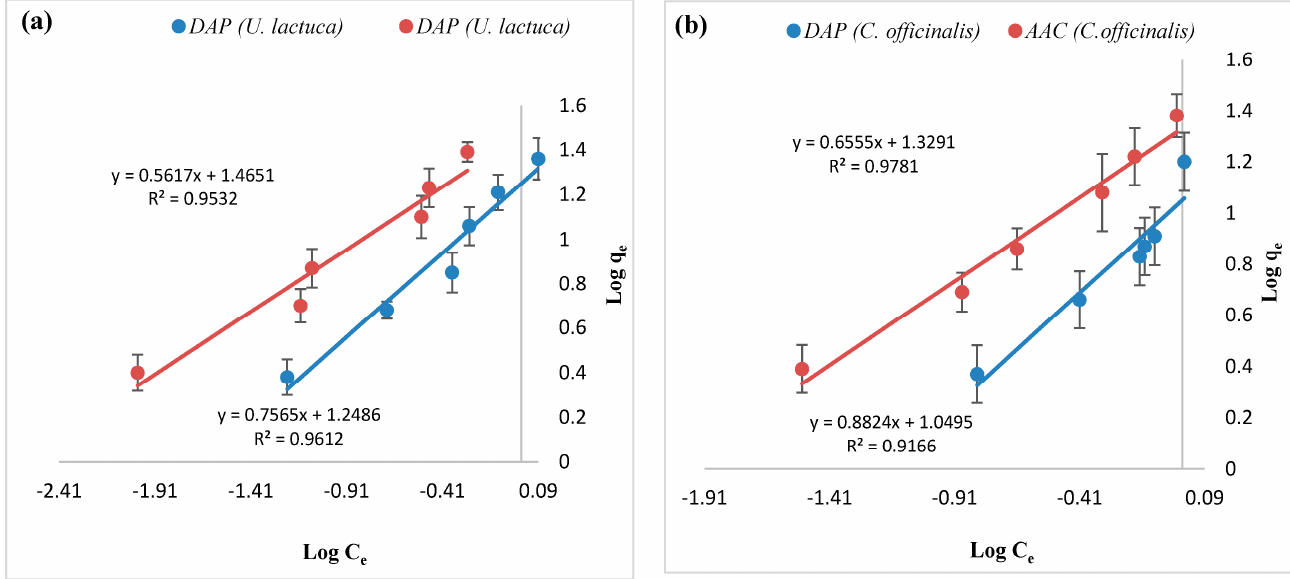
Figure 10. ( a , b ). Freundlich’s adsorption isotherm for Fe +3 on DAP and AAC of ( a ) Ulva lactuca ( b ) Corallina officinalis. Each data point represents the mean ± SD.